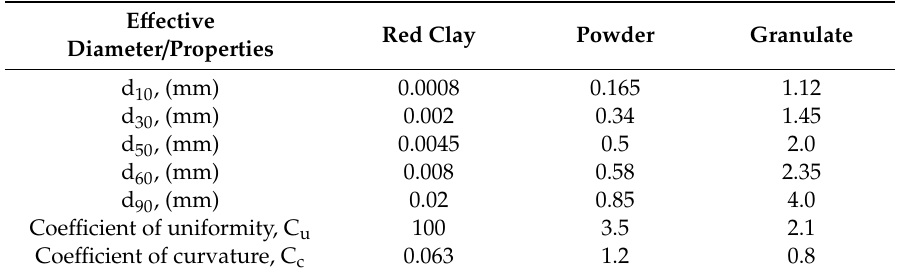
Table 2. Physical properties of the red clay (siCl / CH), powder (P) and granulate (G), based on the grain-size distribution curves